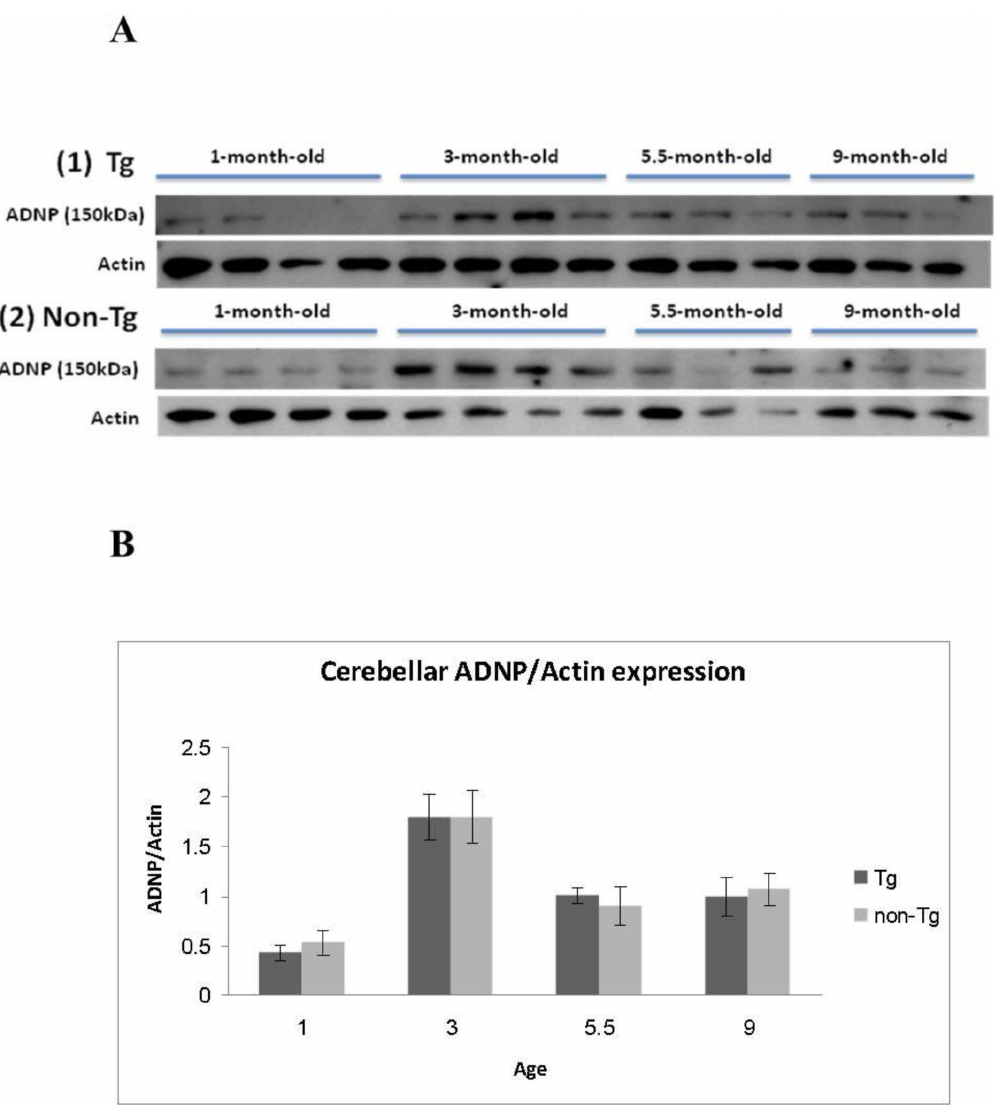
Figure 4. ADNP expression in the cerebellum is not subject to regulation by transgene expression in other brain areas. A] Western blot analysis. Expression of nuclear ADNP in the cerebellum of Tau-Tg mice (1) and non-Tg mice (2) is shown by gel electrophoresis and western blot analysis coupled to quantitative densitometry. Results show an increase in ADNP expression at 3 months of age in both transgenic and non- transgenic mice, followed by a decrease at 5.5 and 9 months of age (each experimental group included 4 mice, 3–4 representatives are shown). B] ADNP quantification in the cerebellum. The ADNP amount in each band was calculated as its percentage from the total amount of all bands, and was then divided by the correlated actin amount of the same sample. ADNP/actin amounts of each group were averaged [Tg: 1-month-old 0.43 + 0.078, 3- month- old 1.794 + 0.228, 5.5-month-old 1.009 + 0.08, 9-month-old 0.998 + 0.195. Non-Tg: 1-month-old 0.532 + 0.125, 3-month-old 1.798 + 0.264, 5.5- month-old 0.903 + 0.196, 9-month-old 0.406 + 0.166]. Four mice were used for each experimental point and gel electrophoresis was repeated twice, average results are shown. Statistical analysis is shown in the text.